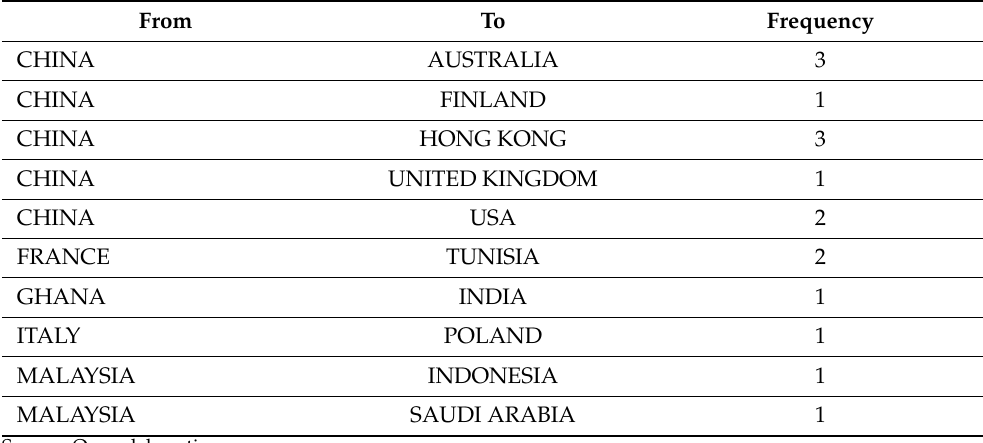
Table 5. Collaboration